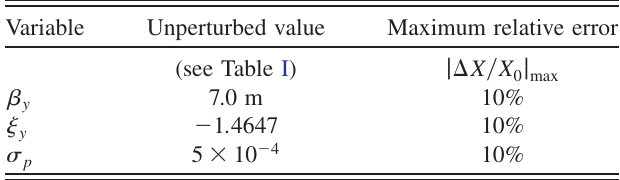
TABLE V. Variables and their assumed maximum systematic relative deviations. Variable